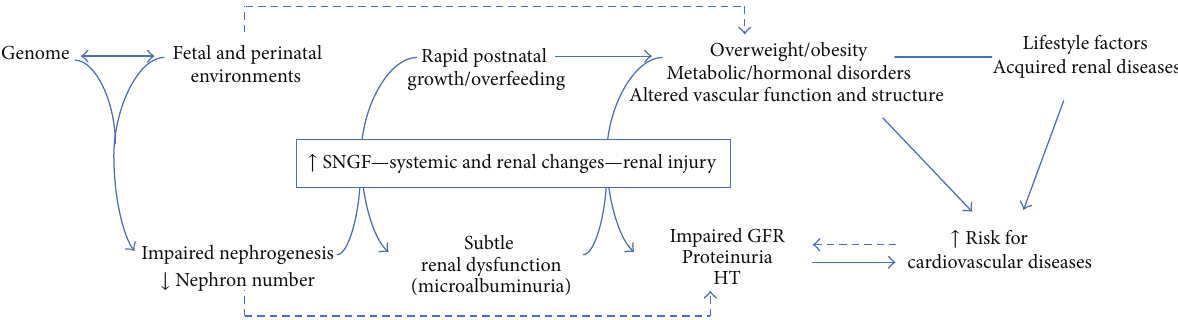
Figure 3: Developmental origin of hypertension and chronic kidney disease: an “integrative